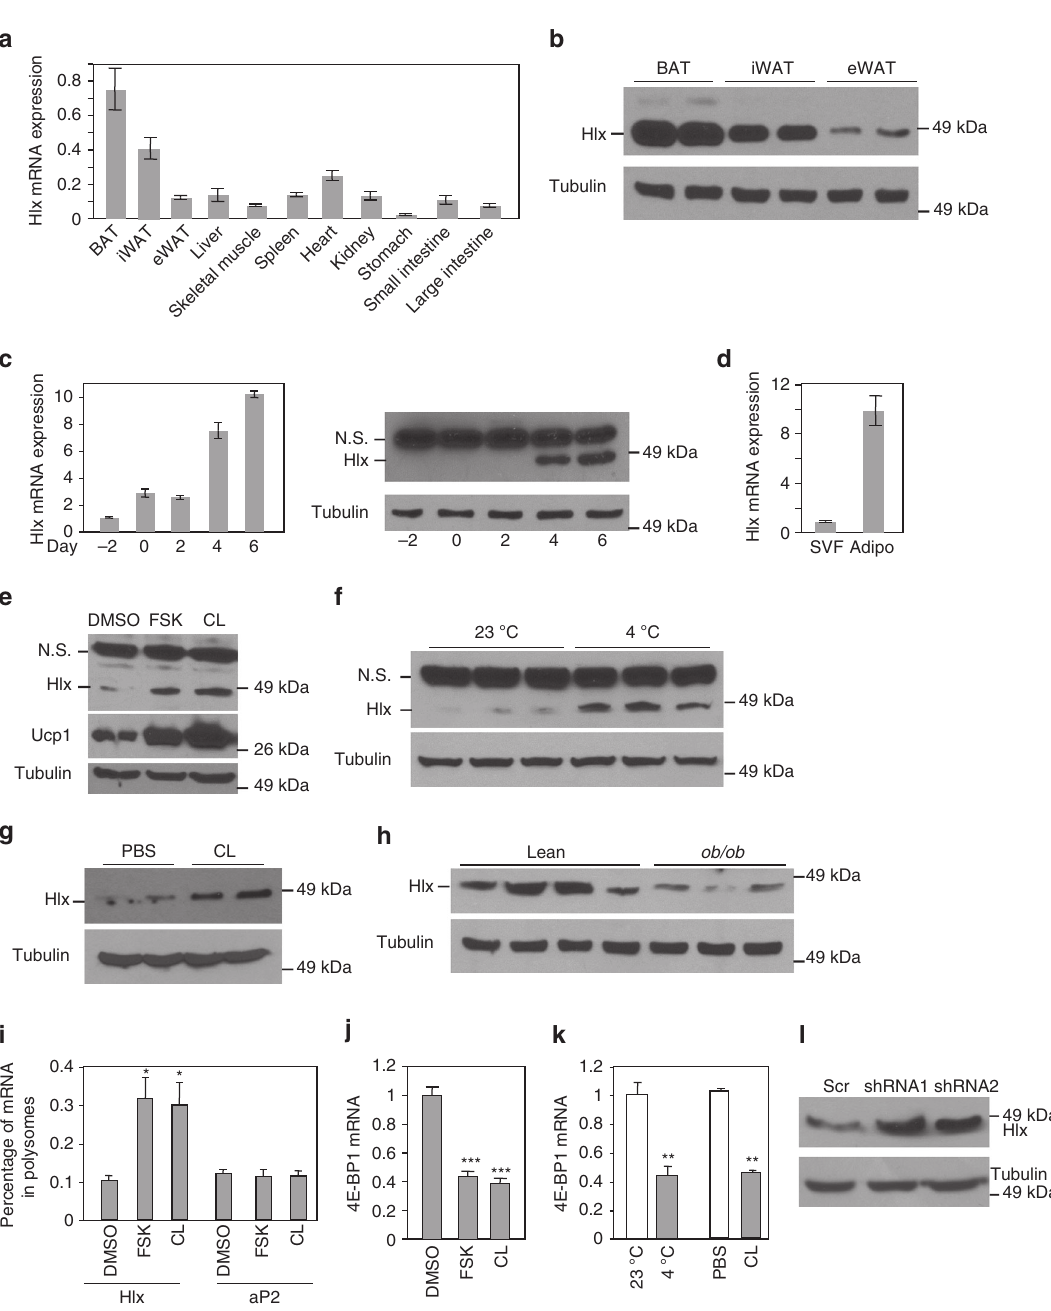
Fig. 1 Hlx is BAT-enriched and is translationally regulated in iWAT by β 3-adrenergic activation. a qPCR analysis of Hlx mRNA expression in multiple tissues from 12-week-old male mice ( n = 4). b Western blot analysis of Hlx protein in different fat depots from 8-week-old male mice. c Hlx mRNA ( n = 3) and protein levels at different time points of in vitro differentiation of immortalized brown preadipocytes. N.S. indicates a non-speci fi c band. d Hlx mRNA expression in stromal vascular fraction (SVF) and mature adipocyte fraction isolated from BAT of 12-week-old male mice ( n = 3). e Western blot analysis of Hlx and Ucp1 protein in in vitro differentiated brown adipocytes treated with Forskolin or CL-316,243 for 12 h. N.S. indicates a non-speci fi c band. f Western blot analysis of Hlx protein in iWAT of 12-week-old male mice at room temperature or cold challenged for 6 h. N.S. indicates a non-speci fi c band. g Western blot analysis of Hlx protein in iWAT of 12-week-old male mice. Mice were intraperitoneally injected with a single dose of CL-316,243 or PBS, and were sacri fi ced 24 h after injection. h Western blot analysis of Hlx protein in iWAT of 3-month-old ob/ob mice and C57BL6 mice. i Polysome analysis. Brown adipocytes treated with Forskolin or CL-316,243 for 9 h ( n = 3). Percentage of Hlx mRNA associated with ployribosome was determined by RT-qPCR. j 4E-BP1 mRNA expression in brown adipocytes treated with Forskolin or CL-316,243 for 9 h ( n = 4). k 4E-BP1 mRNA expression in iWAT of 3-month-old male mice cold challenged for 6 h ( n = 4 mice per group) or injected with a single dose of CL-316,243 ( n = 3 mice per group). l Western blot analysis of Hlx protein in brown adipocytes expressing 4E-BP1 knockdown lentiviruses. All error bars represent s.e.m. Two-tailed unpaired Student ’ s t-test was performed. * p < 0.05; ** p < 0.01; *** p <